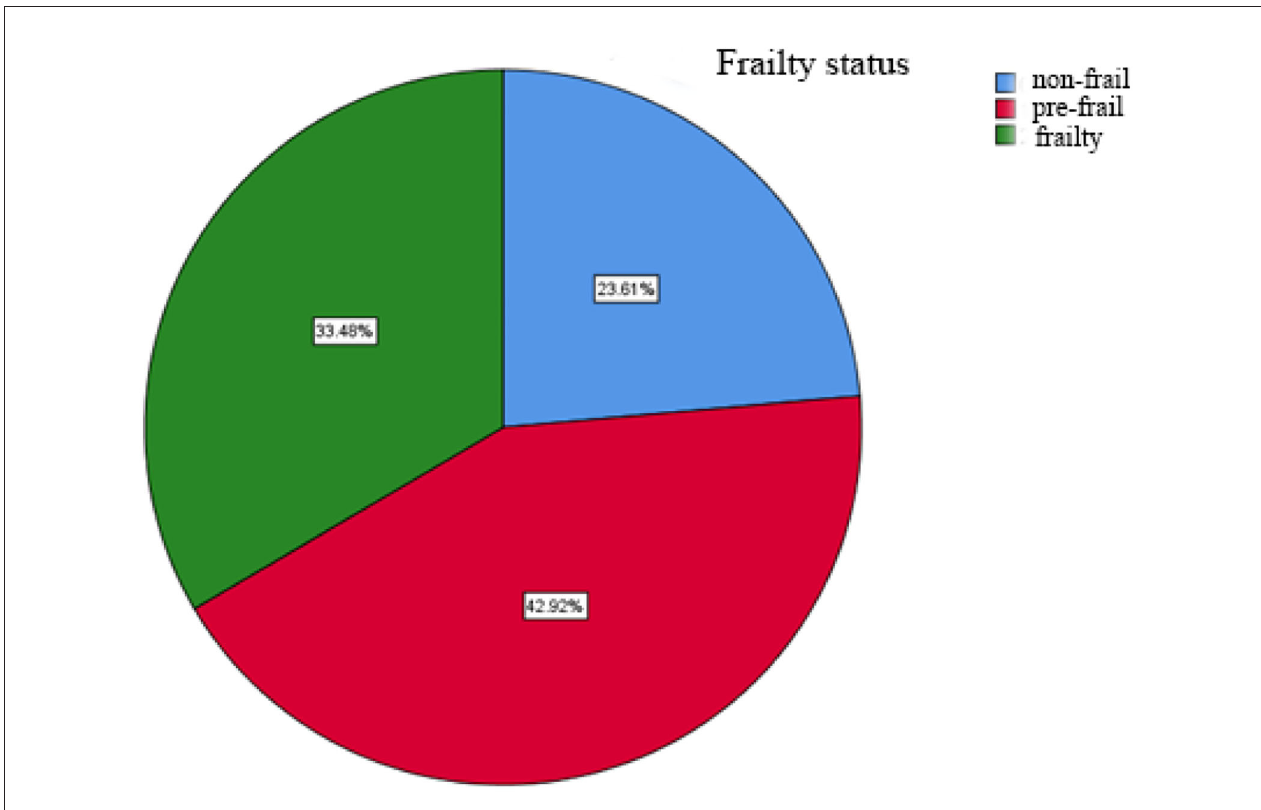
FIGURE 1 | Frailty status of elderly inpatients with CHD.